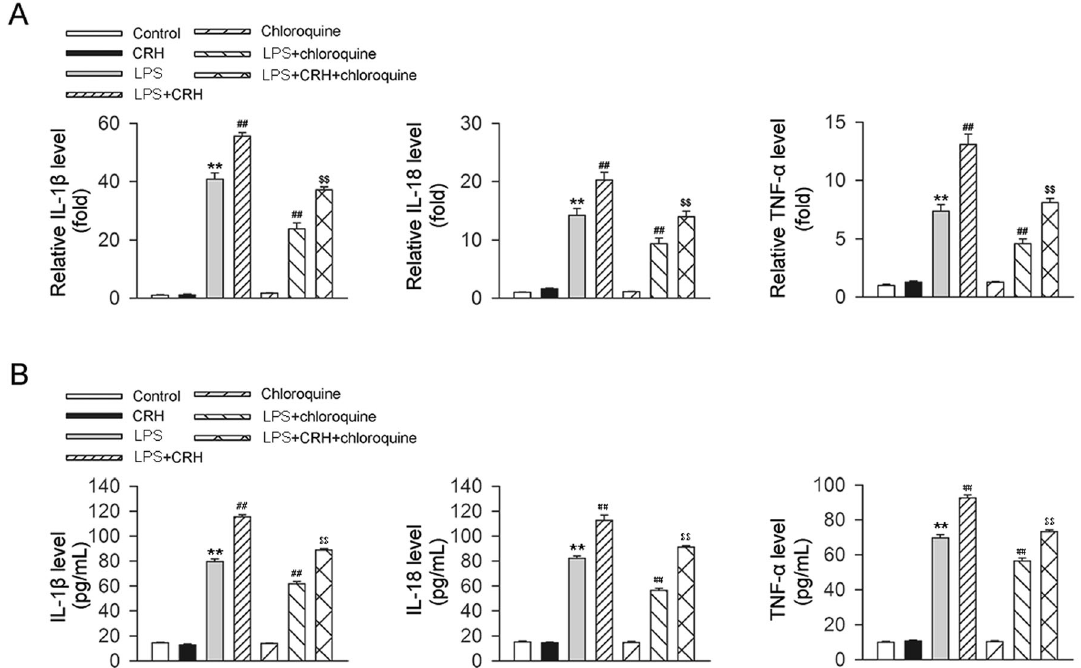
Fig. 7 Chloroquine alleviated the CRH-induced enhancement of in fl ammation in BMDMs under the challenge of LPS. Murine BMDMs were isolated and subsequently stimulated with LPS (100 ng/mL), CRH (10 − 8 M), and/or chloroquine (10 μ M). Real-time qPCR and ELISA were then used to assess the levels of proin fl ammatory factors. In comparison with the LPS + vehicle group, CRH administration further increased the levels of IL-1 β , TNF- α , and IL-18 mRNA ( A ) and protein ( B ). ( n = 6 per group.) ** P < 0.01 vs. the control group; ## P < 0.01 vs. the chloroquine + vehicle group; $$ P < 0.01 vs. the chloroquine + CRH